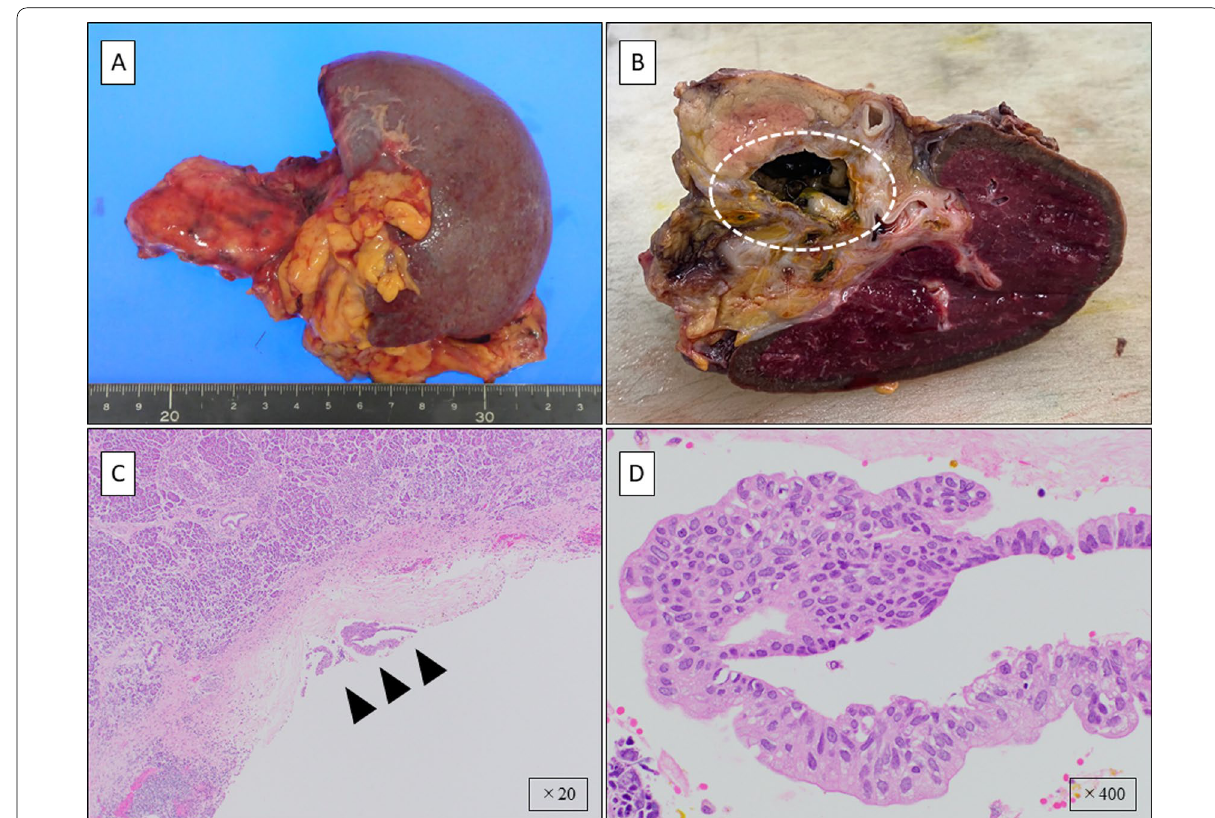
Fig. 4 A Resected specimen. B Pancreatic pseudocyst and embolic coil exposed inside the cyst (circle). C Pathological diagnosis shows pancreatic intraepithelial neoplasia (black arrowhead) ( 20). D Pathological diagnosis shows non-invasive pancreatic intraepithelial neoplasia with the strong × nuclear atypia